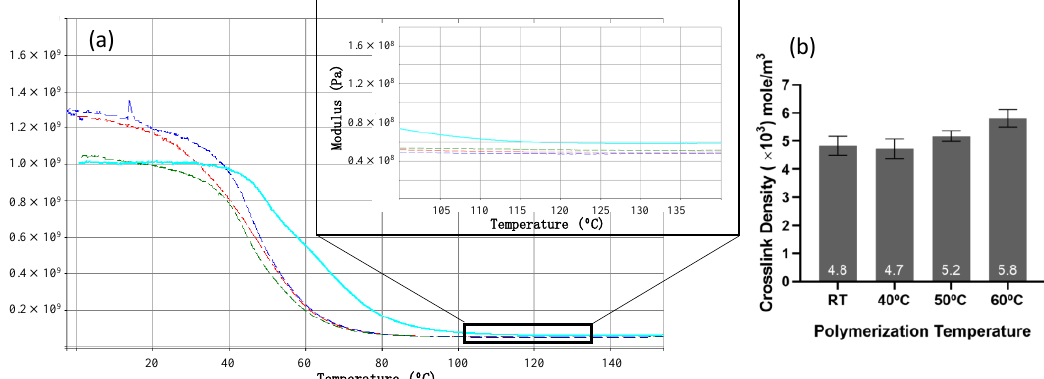
Figure 6. ( a ) Elastic storage modulus (E ′ ) vs. temperature (first scan, 1 Hz), insert: magnified rubber plateau, samples polymerized at RT (red), 40 °C (blue), 50 °C (green), 60 °C (light blue), ( b ) calculated crosslink density. Data are presented as mean with SD.